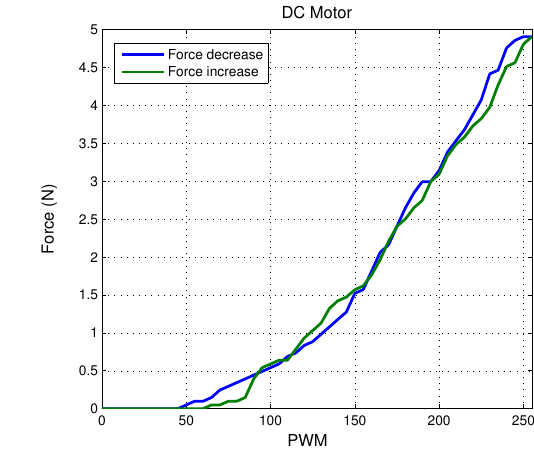
Figure 11. Thruster test.